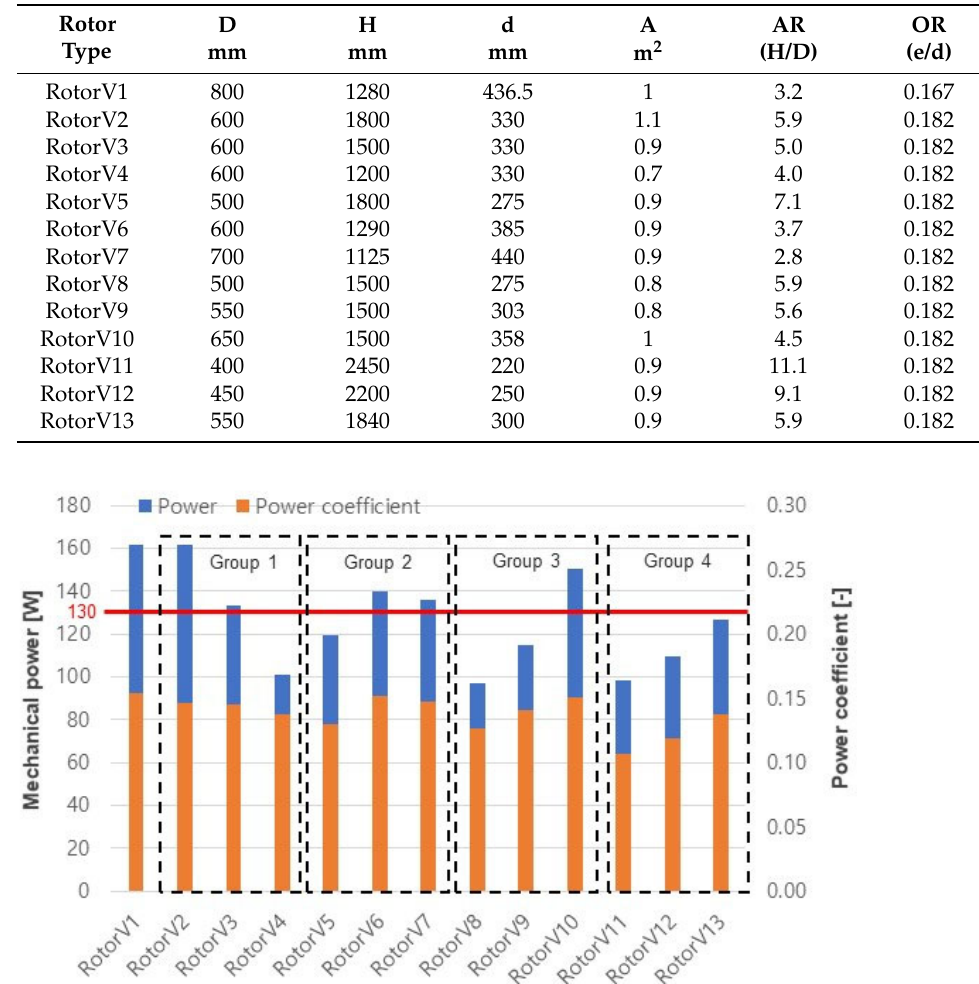
Figure 5. Rotor efficiency changes according to the presence/absence of overlap: ( a ) Rotor geometry comparison, ( b ) Rotor power. Table 1. Definitions of design parameters and analysis cases for a semi-circular rotor.